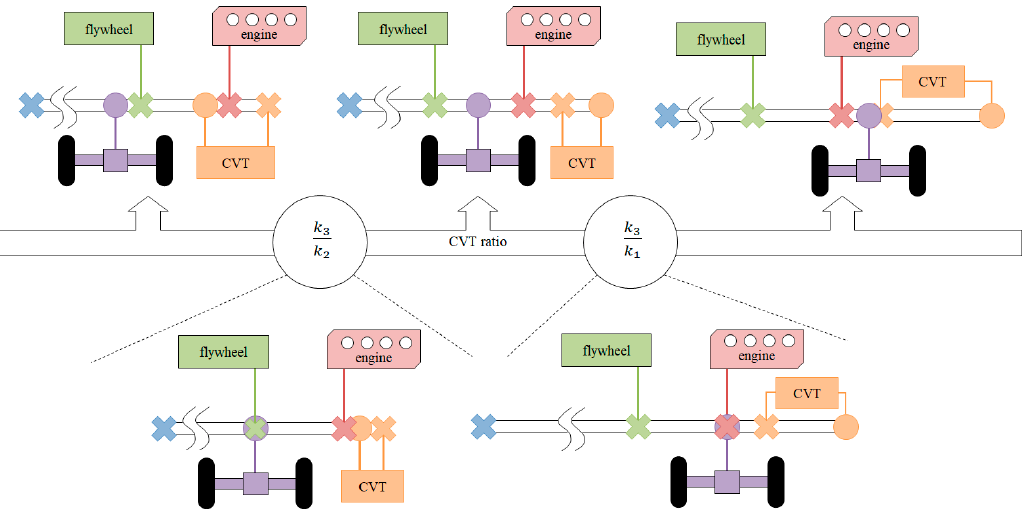
Figure 5. Changes in node location in the single lever expression of the PS-FHV with change of CVT ratio.